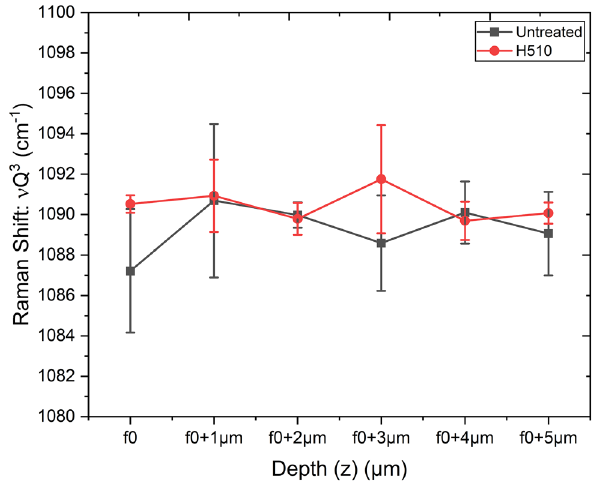
Figure 6. Comparative Raman shifts of the position of the high-frequency Q 3 stretching band with depths up